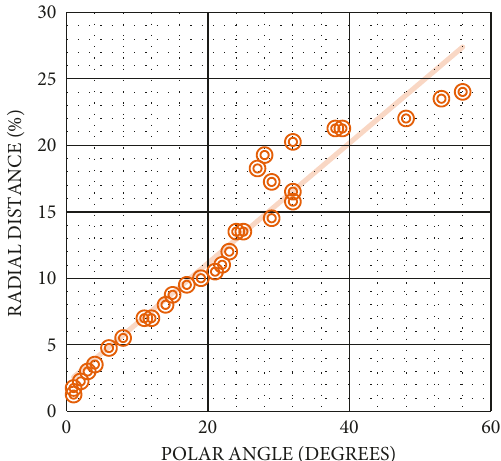
Figure 2: Linear regression of the ( θ ,r ) of the peaks of the left line (corresponding to the top arm of the galaxy) of the bottom galaxy in Figure 1.